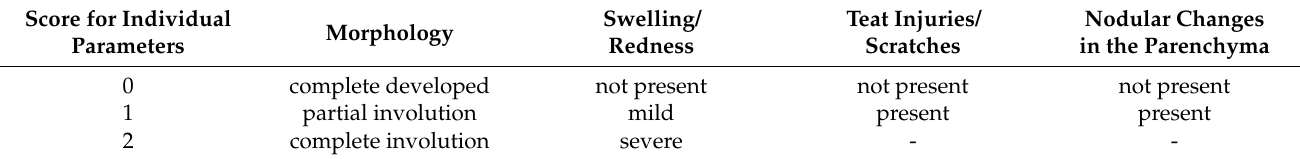
Table 1. Scoring system of individual clinically recorded parameters for assessing the sow